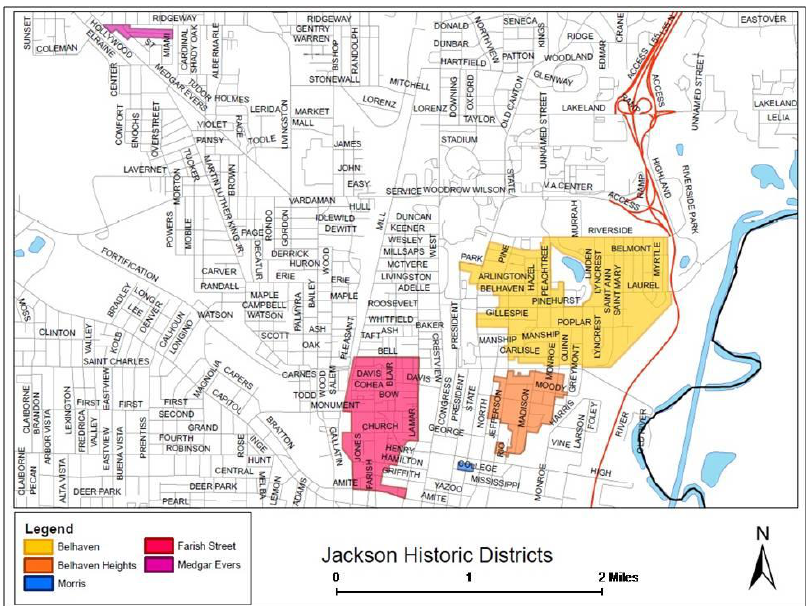
Figure 10. Historic districts in the City of Jackson (Source: www.jacksonms.gov